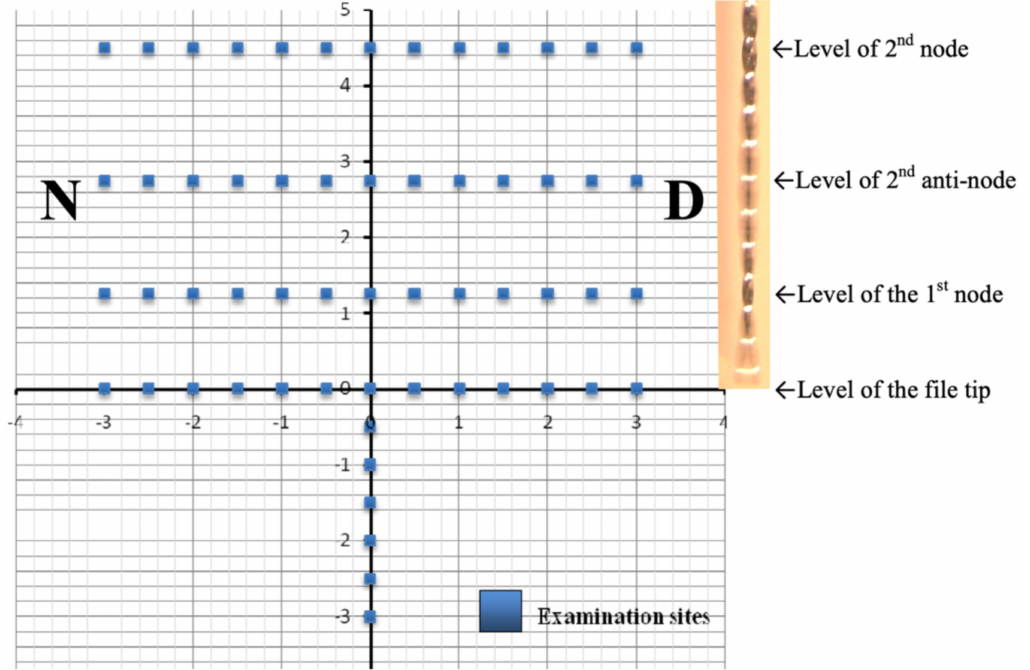
Figure 3. Schematic representation of the 58 examination sites, with the file aligned on the Y-axis and its tip situated at the origin. (Note: A photo of the vibrating endosonic file was inserted to illustrate the locations of the nodes and